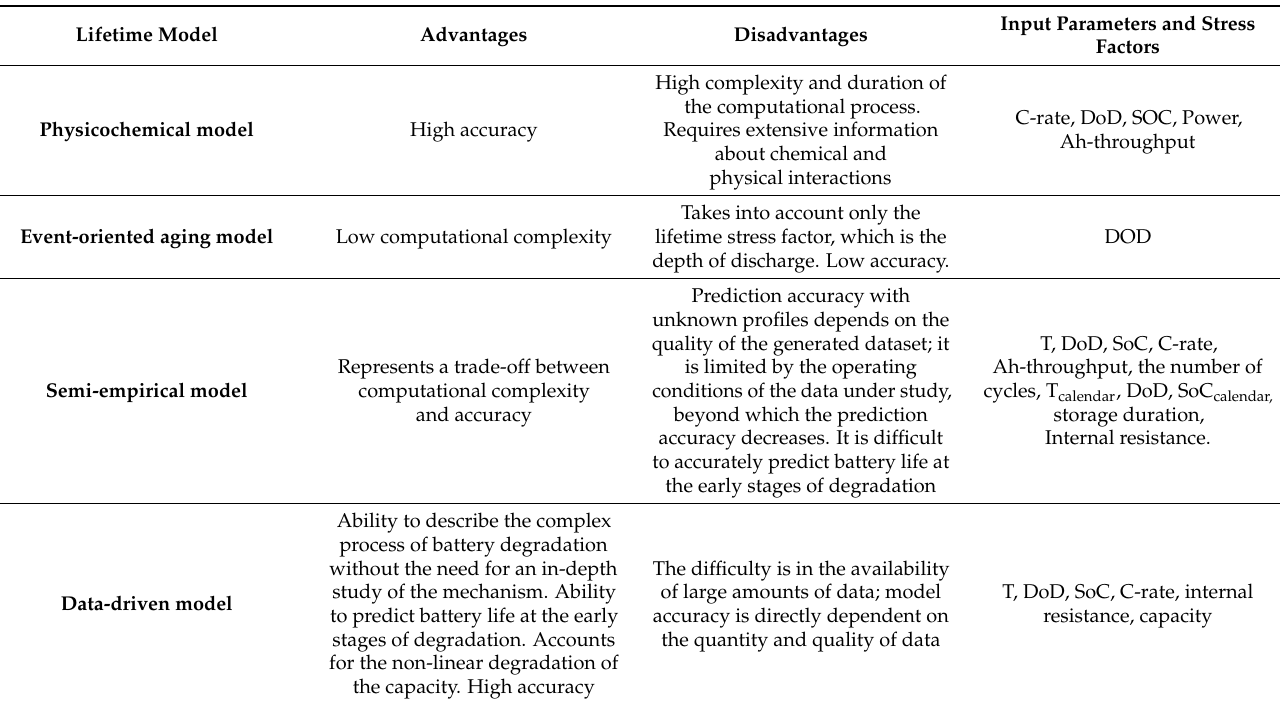
Table 3. Advantages and disadvantages of lifetime models